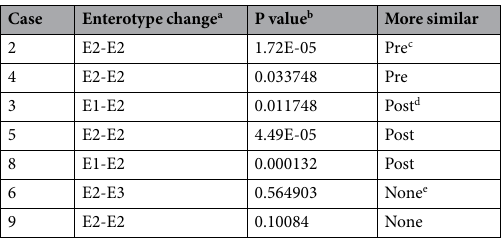
Table 2. Changes to gut microbiota composition following LT surgery. a Enterotype change represents the enterotype of individual samples taken before (pre, left) and after (post, right) LT. b Based on a unilateral Wilcoxon rank sum test of the weighted unifrac distances between the pre-LT or post-LT sample and samples from the 15 healthy controls. c Pre indicates that the weighted unifrac distance from the pre-LT sample to the healthy control samples is shorter than that from the post-LT sample to the healthy controls samples. d Post indicates that the weighted unifrac distance from the post-LT sample to the healthy control samples is shorter than that from the pre-LT sample to the healthy control samples. e None indicates that there is no significant difference ( p > 0.05) in the weighted unifrac distances to the samples from the 15 healthy controls between the pre-LT and post-LT